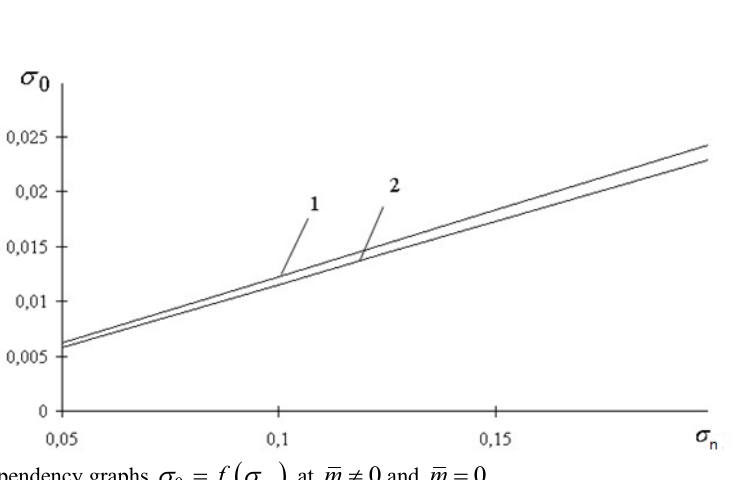
Fig. 9. Dependency graphs